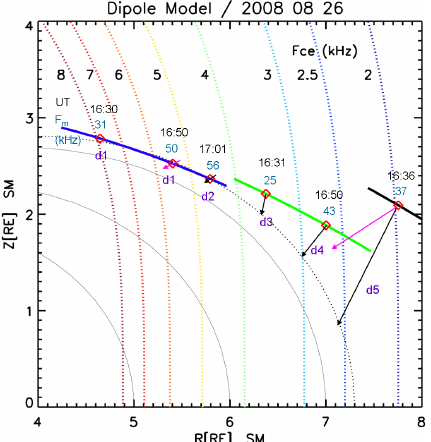
Figure 8. Meridian view during the 26 August 2008 event, with L shells and isoFce contours of a simple dipolar model, as in Figs. 2 and 4. An indicative plasmapause shell is drawn at L = 7.4. The Cluster orbit elements during the event are displayed respectively in blue for C4, green for C3 and black for C1. Positions of the satellites at the times corresponding to individual spectra shown in Figs. 5 to 7 are marked by a red diamond symbol. Black arrows indicate backward ray paths of NTC radiation between view points and cor- responding source positions. Pink arrows are aligned with indica- tive orientations of the ray path derived from directivity properties. Three pieces of information are given for each chosen satellite posi- tion: UT times, frequencies F m of main frequency peaks (shown in Figs. 5 to 7) and labels (d1 to d5) referring to the distance between a source and the associated view point (see text in Sect. 4.4).